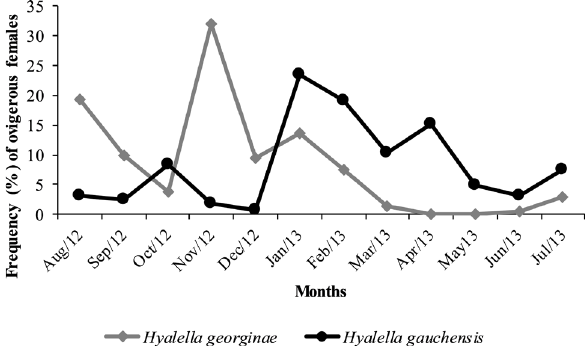
Figure 6. Frequency of ovigerou females of Hyalella georginae and Hyalella gauchensis carrying eggs or juveniles in the brood pouch along year of study, Palmeira das Missões, state of Rio Grande do Sul, Brazil.